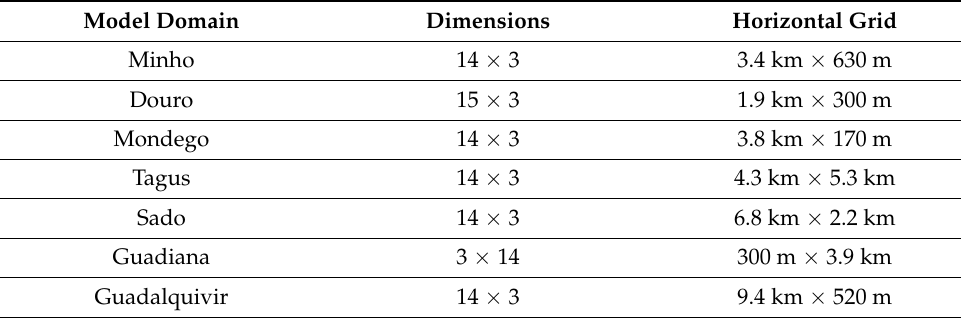
Figure 1. Representation of the study area as well as the most important bathymetric features and location of the time series used in the validation of the results. The area corresponds to the PCOMS grid domain (Level 2) and its bathymetry (on the map). Level 1 is not shown in the figure, as it is equal to that of Level 2 but with 2 more numerical cells in each direction. On the right side, a representation of the schematic river and estuary domains is shown. In this case the dimensions of these estuary and river domains are shortened in order to fit in the image. Their real dimensions are presented in Table 1. Table 1. Dimensions of the schematic river and estuary